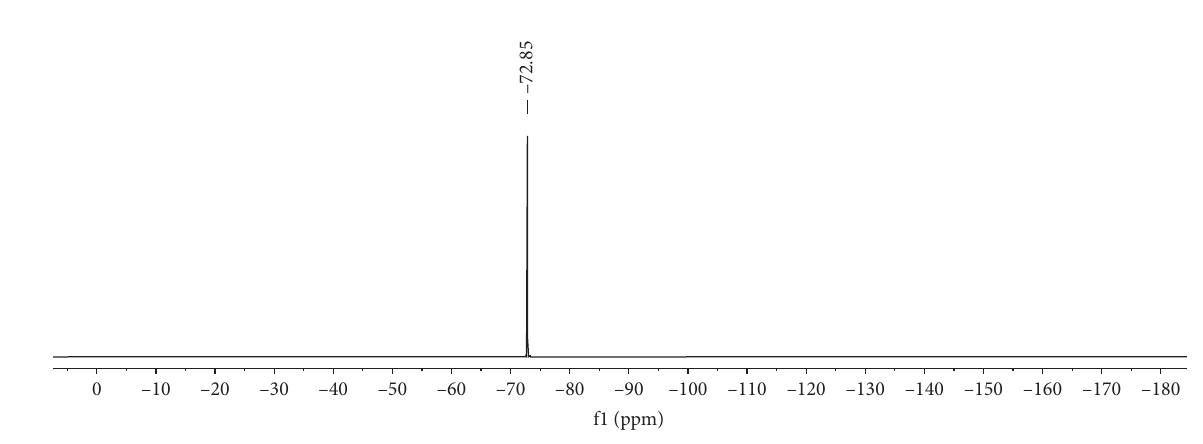
Figure 3: 19 F{ 1 H} NMR spectrum of compound 1